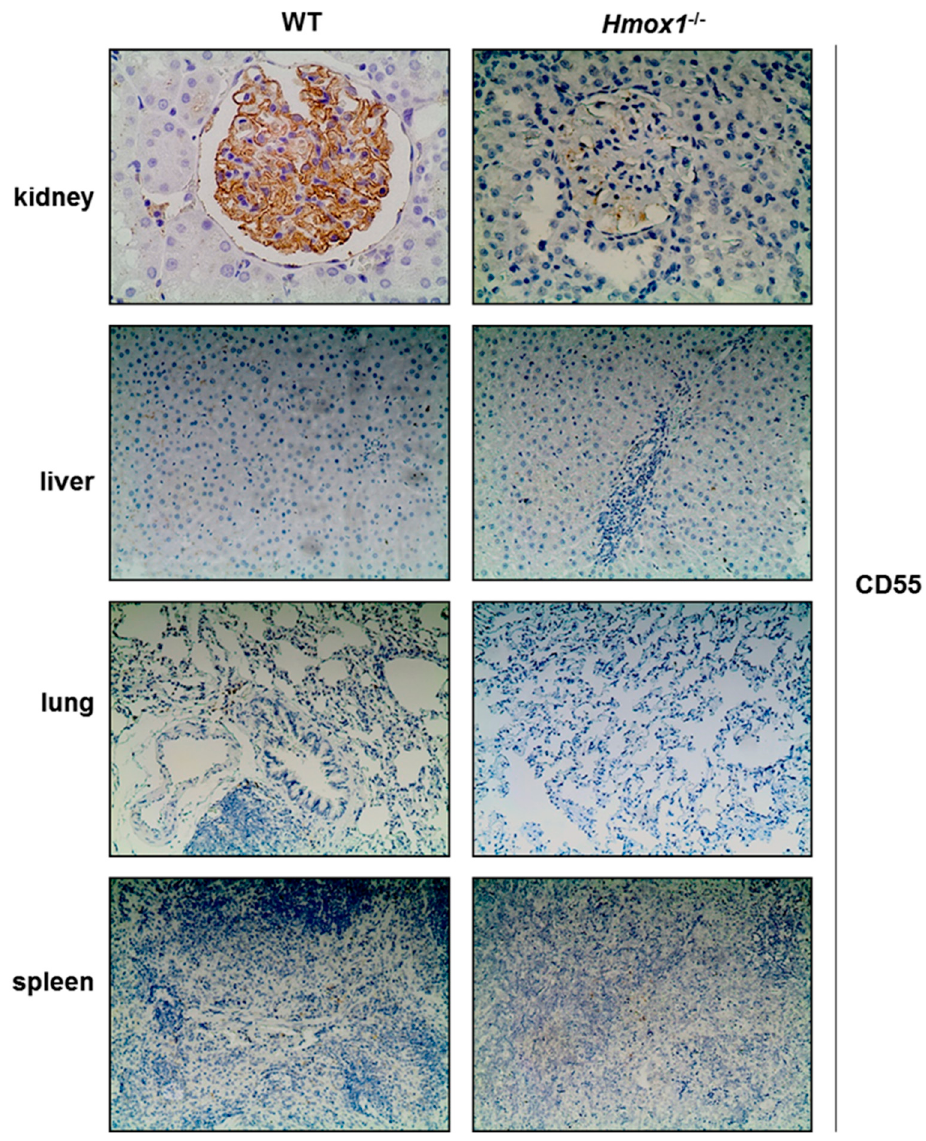
Figure 1. Immunostaining of DAF in tissue sections obtained from WT and Η mox1 − / − rats. Reduced DAF staining was observed in kidney, liver and lung tissue. No apparent differences in DAF staining in spleen tissue sections were shown in Η mox1 − / − rats. Magnification ×200. Table 1. CRP and C3aR expression in WT and Hmox1 -/- tissue samples and C3b deposition.